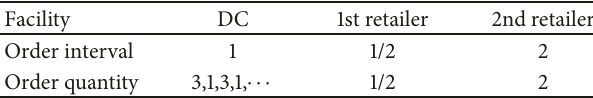
Table 1: The order intervals and quantities in the